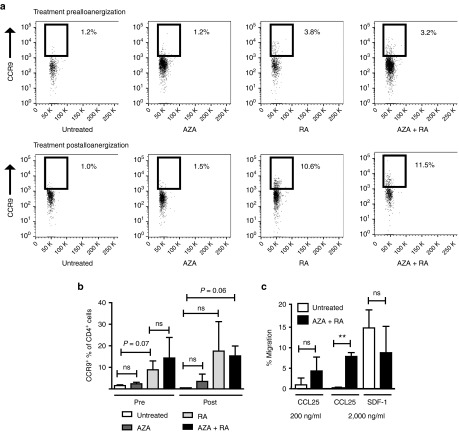
Pharmacological treatment can partially correct defective CCR9-specific chemotaxis of regulatory T-cells (Treg) expanded after alloanergization. (a) Azacitidine (AZA) and all-trans retinoic acid (RA) treatment prior to or after alloanergization increases the proportion of expanded Treg expressing CCR9. Illustrative dot pots are shown depicting CCR9 expression on CD4+ FOXP3+ Tregs after alloanergization with and without treatment with AZA, RA or both. Representative data are shown from one out of six experiments. (b) Mean frequencies (±SD) of cells expressing CCR9 expressed as a proportion of Treg after alloanergization without and with treatment with AZA, RA or both. ns, not significant. Individual P values where there was a trend to statistical significance (P > 0.05 < 0.10) are also shown. (c) CCL25 and stromal cell-derived factor 1 (SDF-1)-specific chemotaxis of CD4+ Treg from AZA/RA treated or untreated alloanergized PBMCs. Bar charts depict mean (±SD) data from three different stimulator-responder pairs. **P < 0.01, ns, not significant.